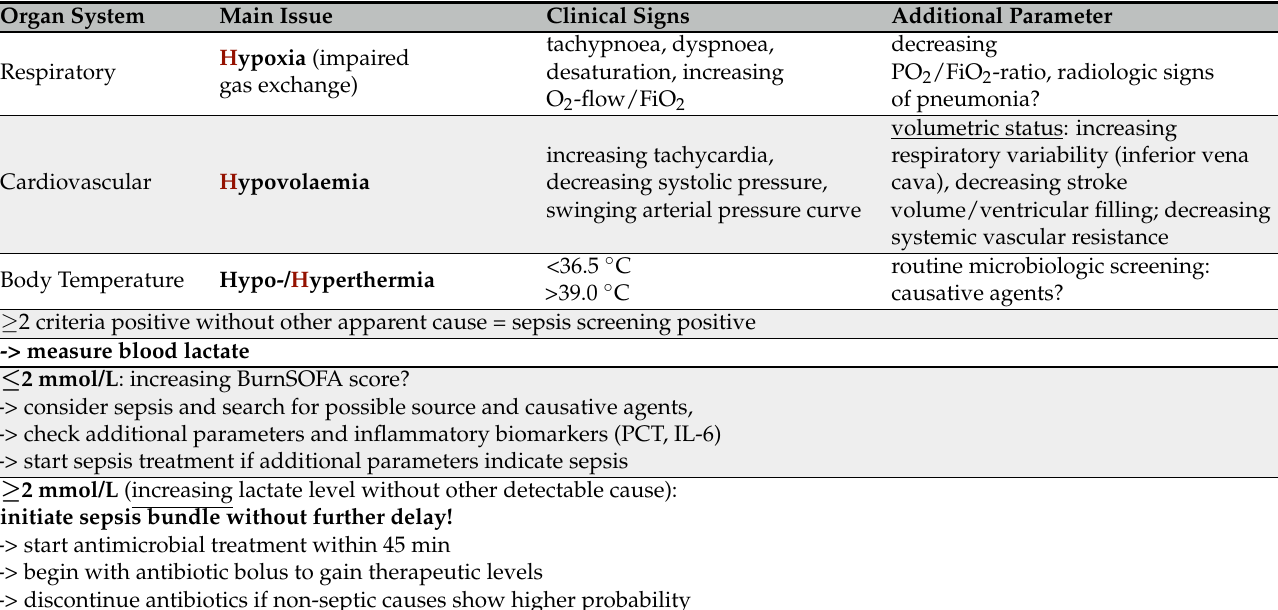
Table 3. The 3 H’s of burn